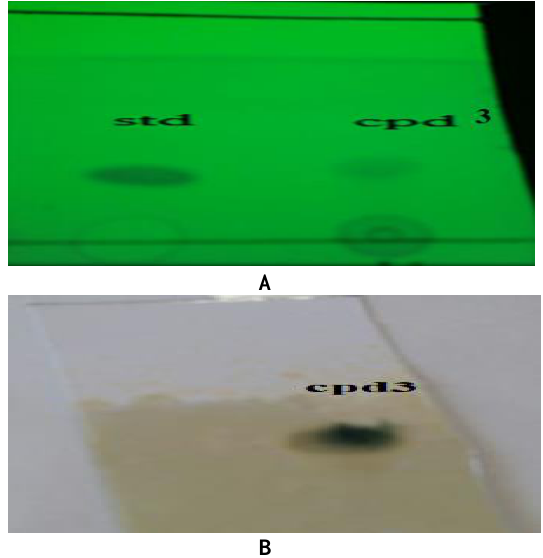
Figure 11. TLC chromatography (A) for separated compound number (3) from ethyl acetate fraction and Caffeic acid STD using silica gel Gf254 as adsorbant and S1 as mobile phase and (B) separated compound number 3 after detected by spraying with five %ferric chloride.